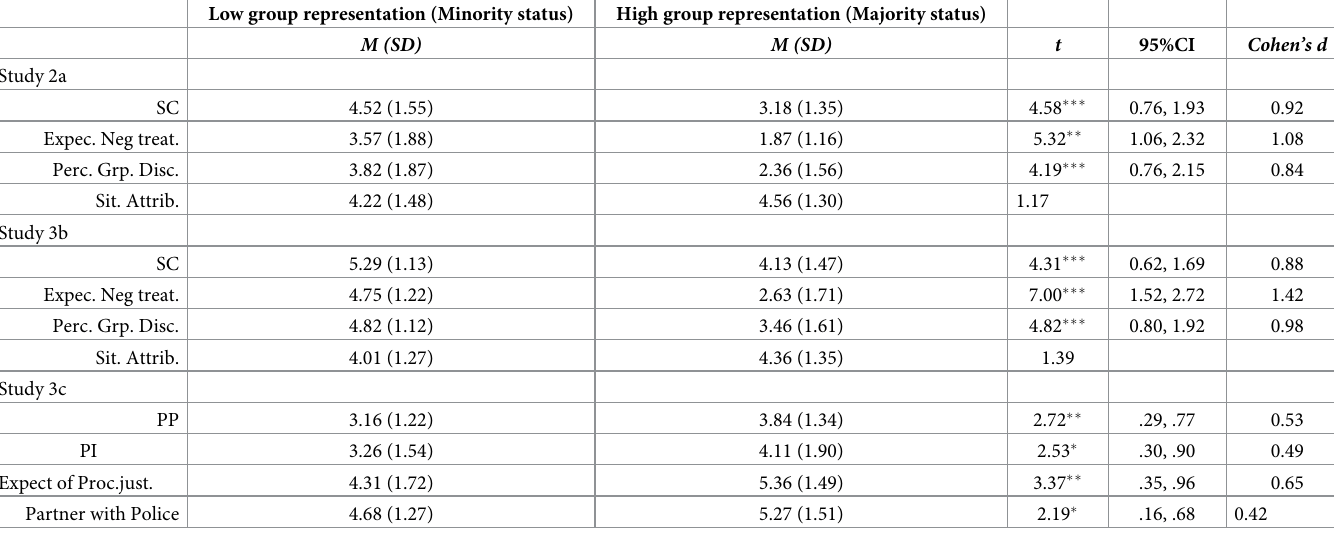
Table 4. Tests for the effect of group representation on self-categorization and outcome variables (Studies 2a, 2b, &